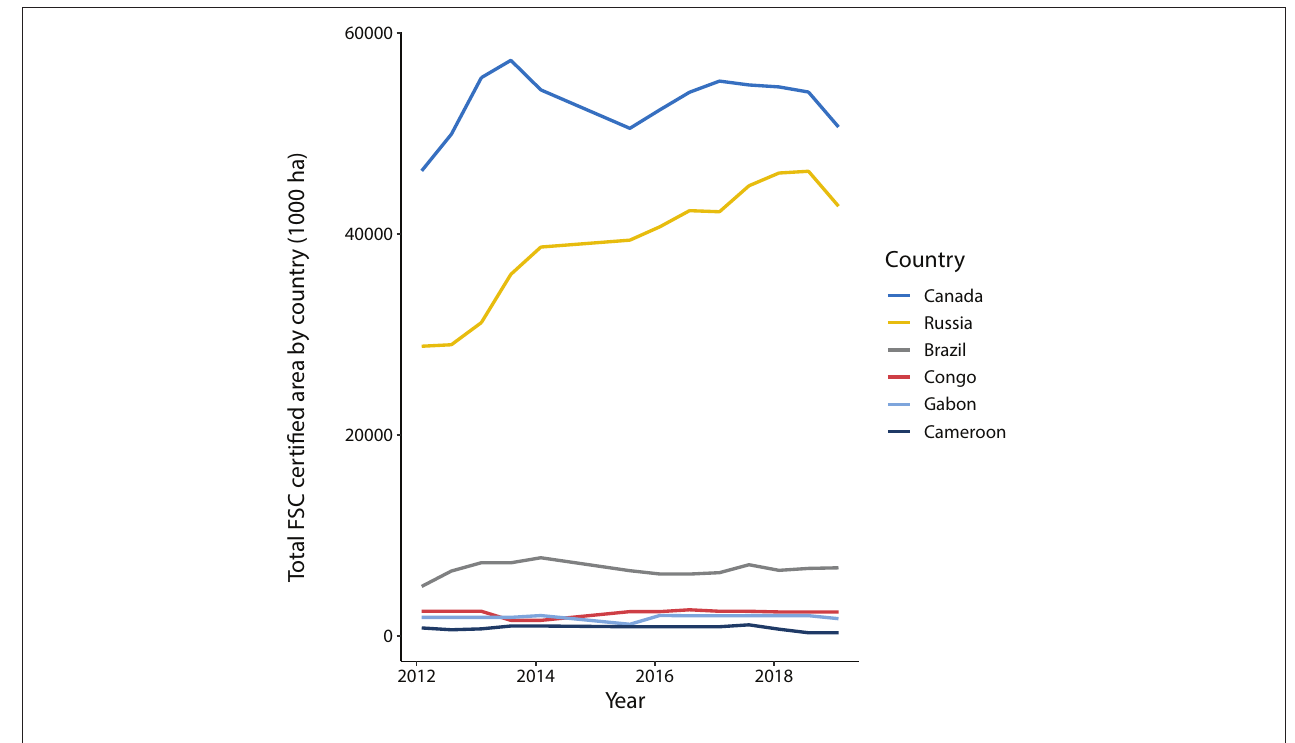
FIGURE 2 | Total FSC certified area between 2012 and 2019 in six countries with large IFL (source: https://fsc.org/en/page/facts-figures).